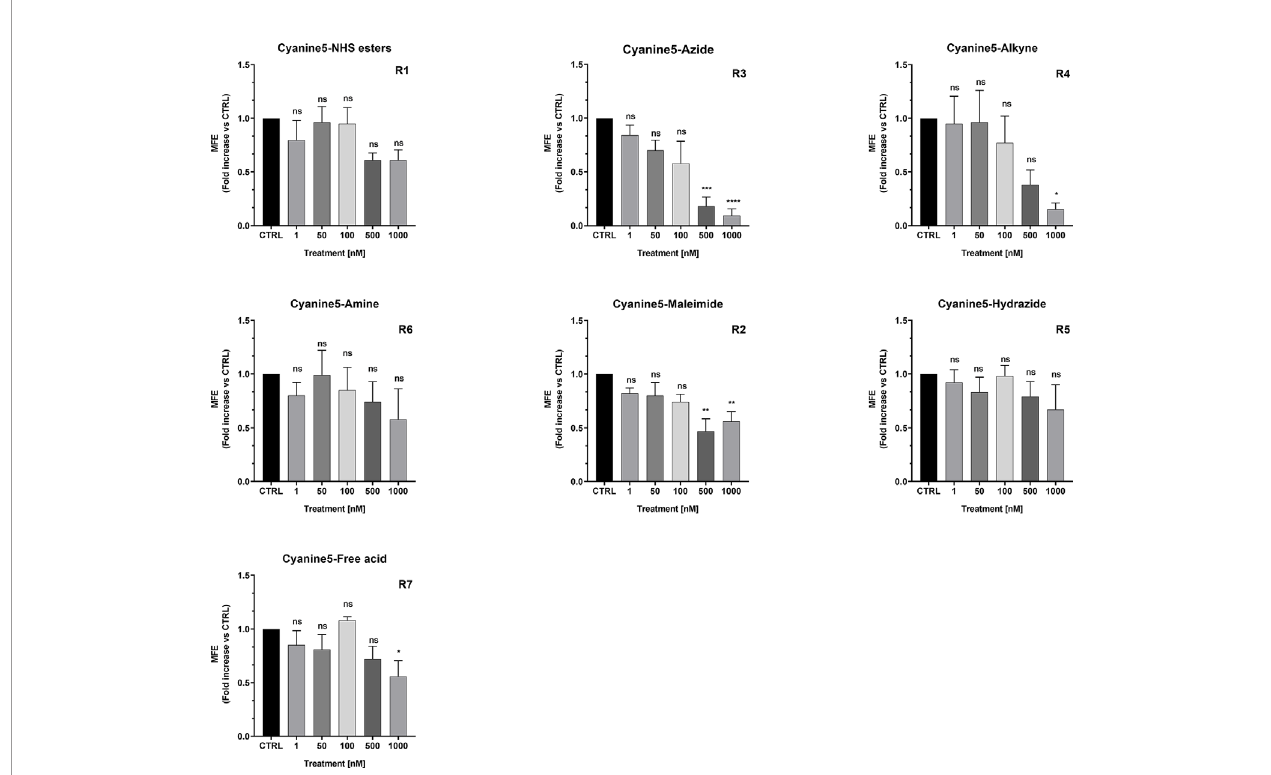
FIGURE 11 | Effects of Cyanine 5 on 3D mammosphere formation in MCF7 cells. MCF7 mammospheres cells were treated with different concentrations of each compound (1, 50, 100, 500 and 1,000 nM) for fi ve days. Mammospheres >50-µm were counted manually using a bright fi eld microscope (n = 4). Data is expressed as fold increase Vs control. Statistical analysis was conducted using one-way ANOVA.